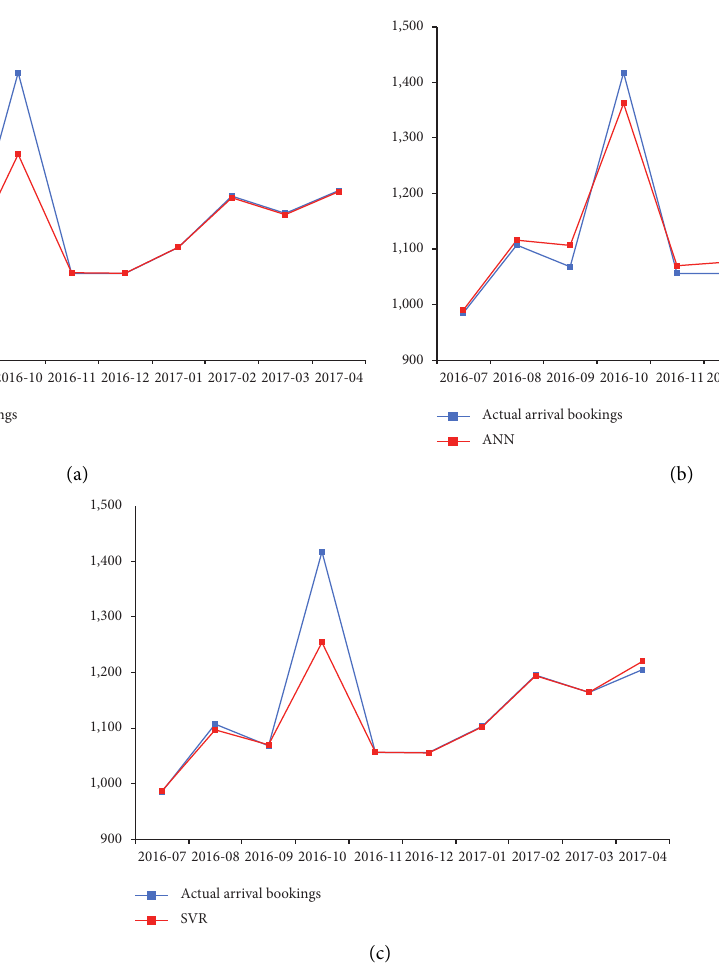
Figure 4: Comparison of the fitting curves of each model in training